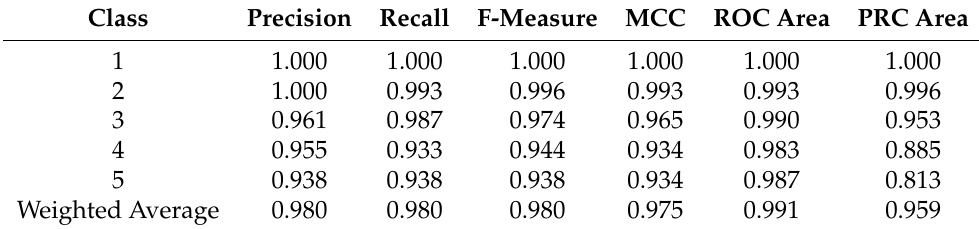
Table 16. DTNB Accuracy Details.